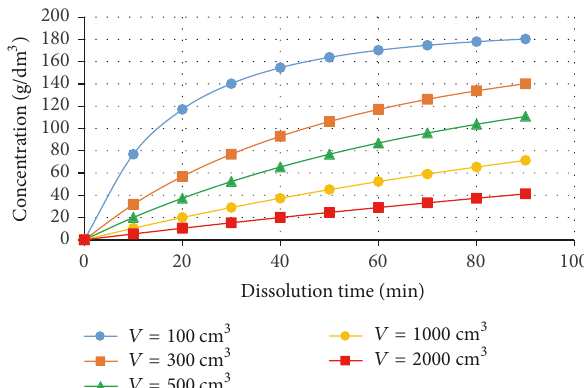
Figure 11: Change of the concentration of rock salt with dissolution time for different initial volumes ( 𝑉